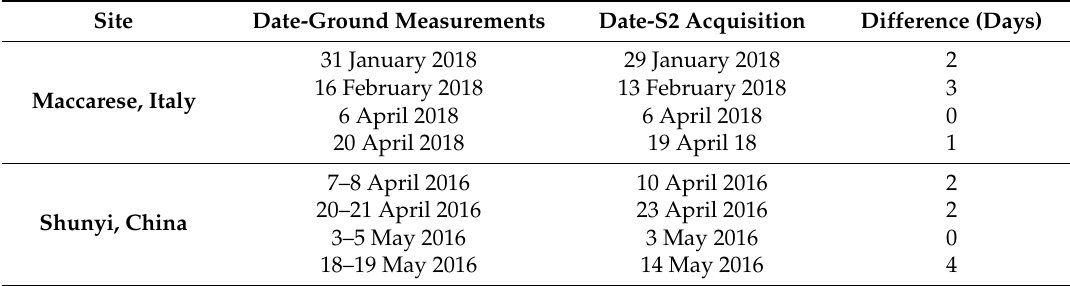
Table 3. Sentinel-2 acquisitions and ground measurements